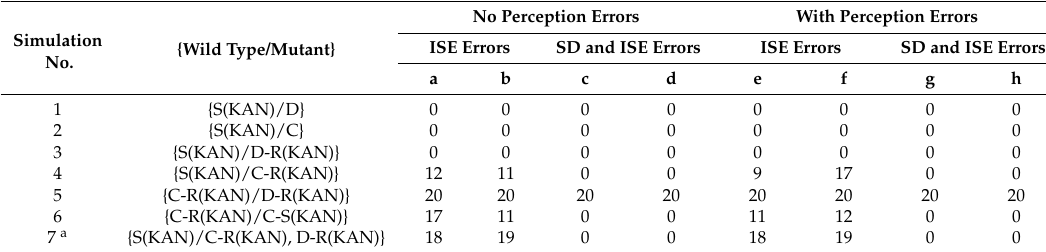
Table 7. Frequency of successful invasions under kandori .